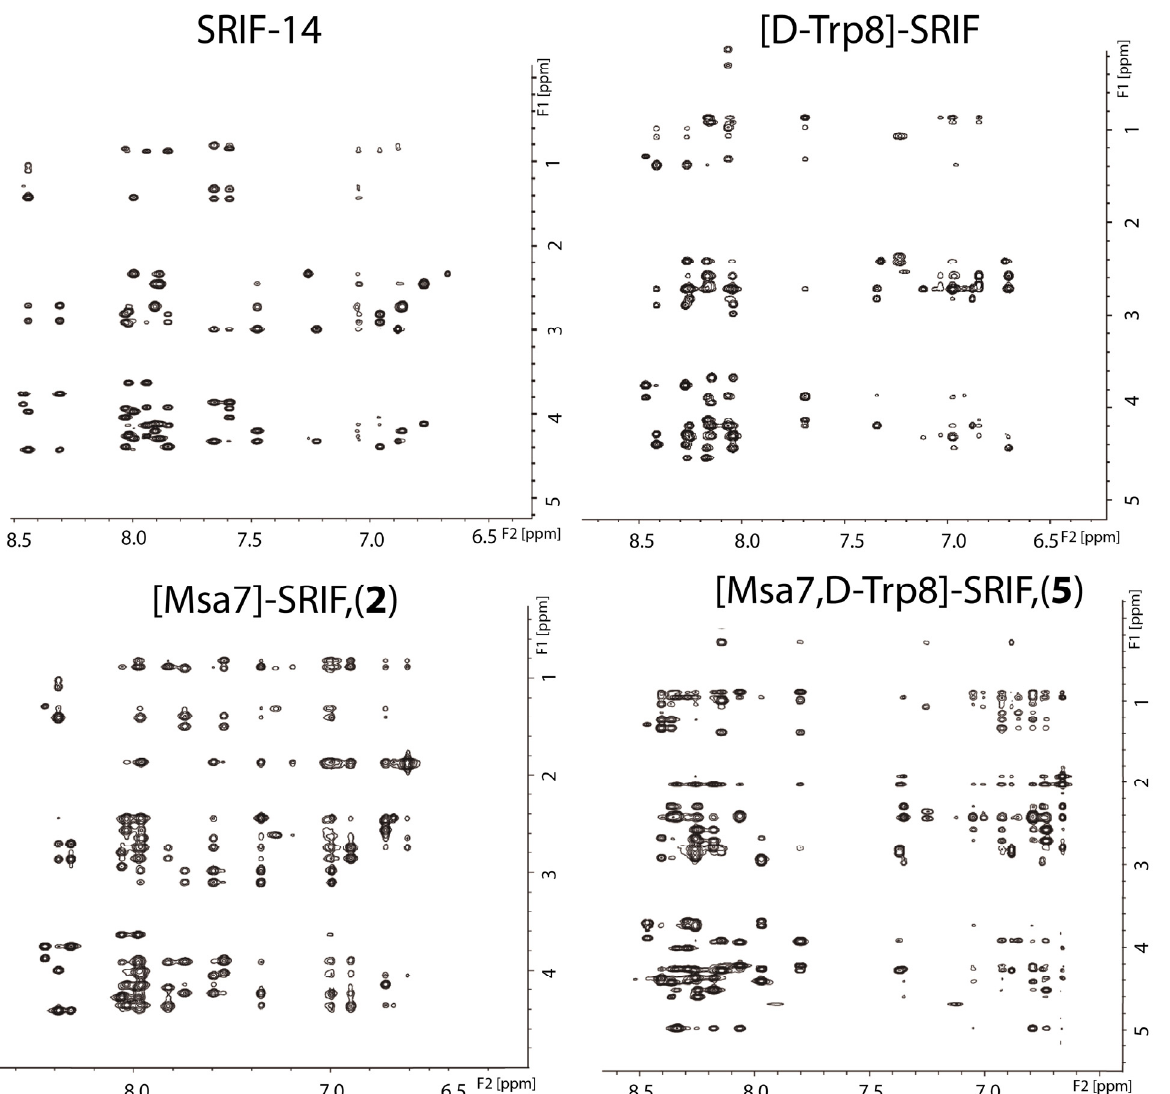
Figure 5. NOESY (600 MHz, D O, 200 ms) of the aromatic ring-long range interaction 2 region of the natural hormone, [ D -Trp8]-SRIF, [ L -Msa7]-SRIF ( 2 ) and [ L -Msa7, D